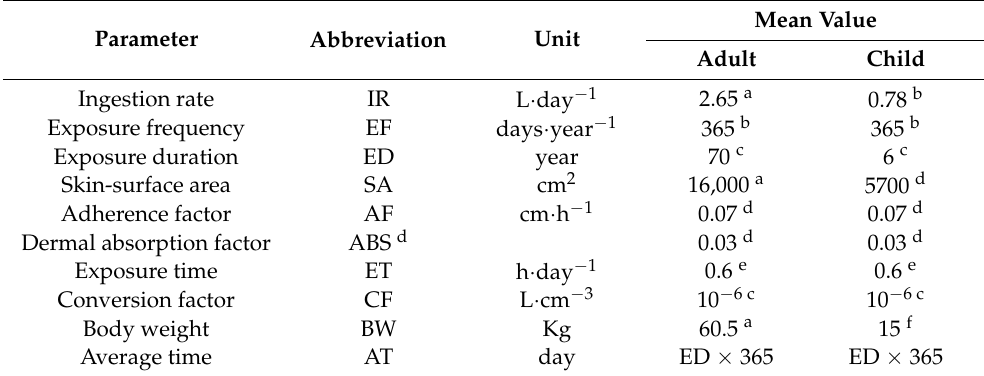
Table 1. General parameters of the health risk assessment for heavy metals in river water.